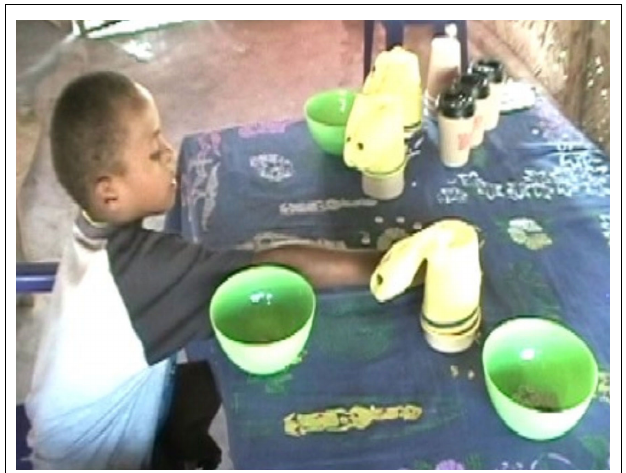
FIGURE 6 | Experimental situation in Samoa. The plush puppets and poker chips used for the American samples were replaced with more culturally familiar items (sock puppets and